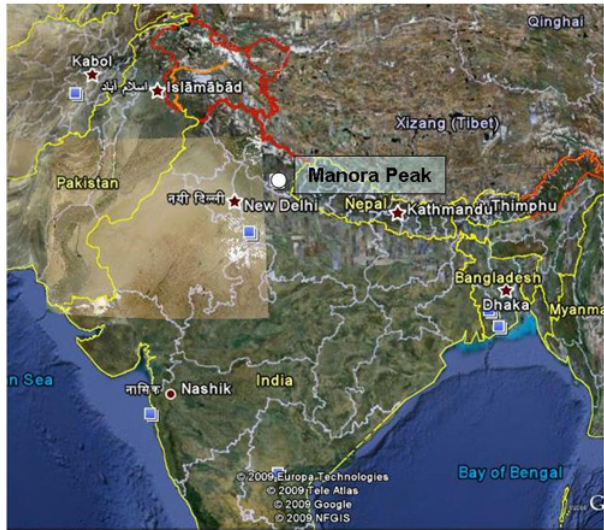
Fig. 1. The sampling site, Manora Peak (white circle) located at the foot-hills of central Himalaya. A major dust storm that occurred on 12 June 2006 over the Indus Valley (along the border between Pakistan and India) is also shown in the picture (brown rectangle). This dust-storm had resulted in the high TSP abundances and AOD values at Manora Peak. The event was captured by the Moder- ate Resolution Imaging Spectroradiometer (MODIS) flying onboard NASA’s Aqua satellite on 12 June 2006 (http://earthobservatory. nasa.gov) and was combined with the Google Earth.